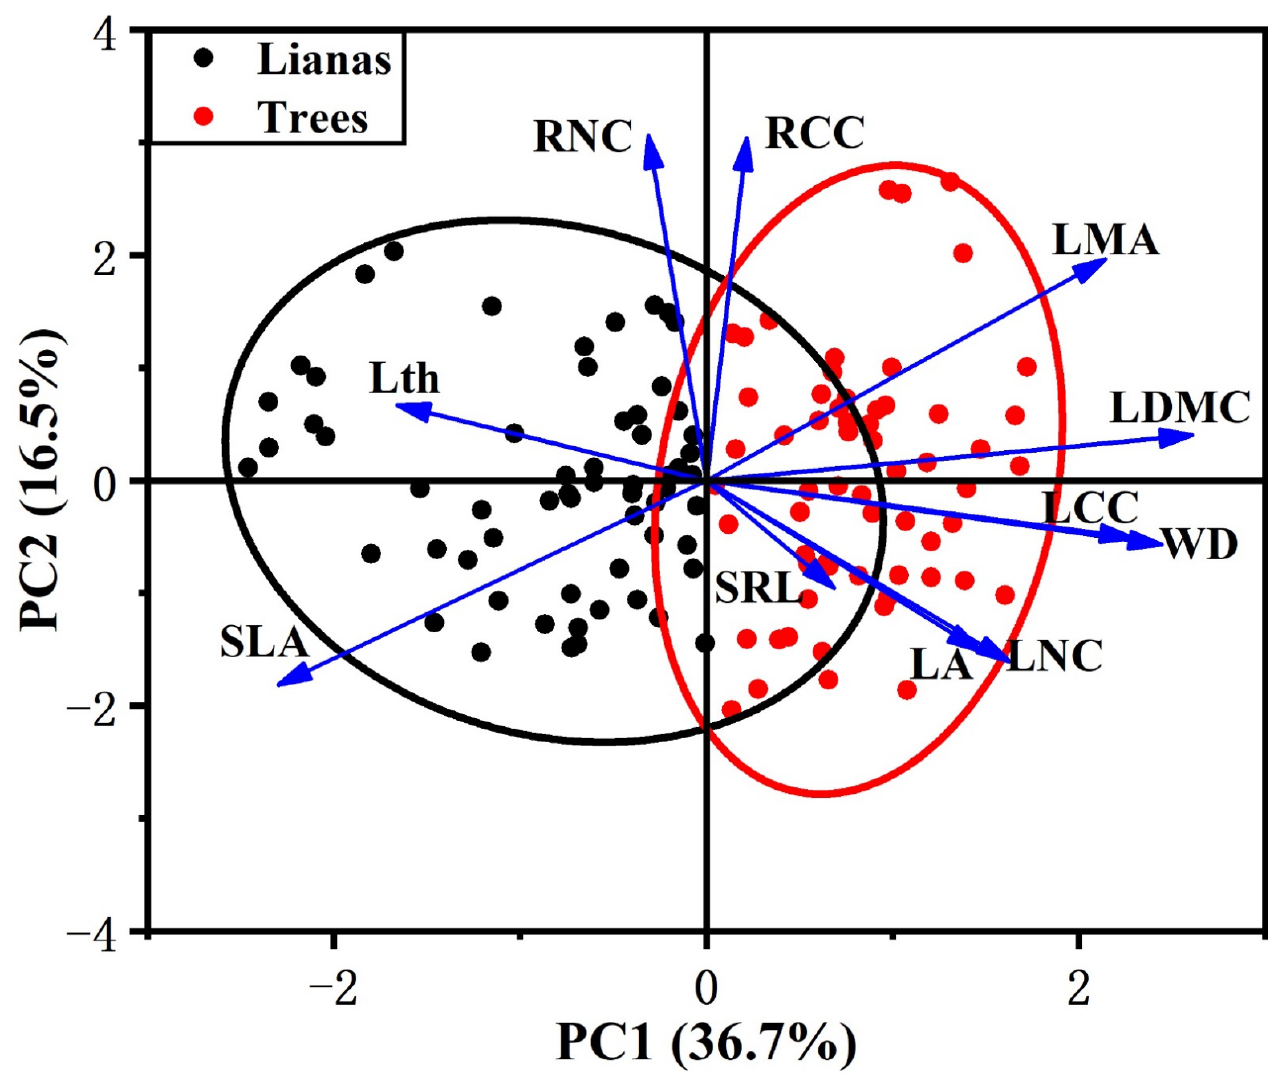
Figure 1. Distribution of lianas and host trees in traits space defined by the first two PCA axes. Black represents lianas, red represents trees. Confidence ellipses are represented for each life form (lianas and trees). For explanation of abbreviations, see Table 1.